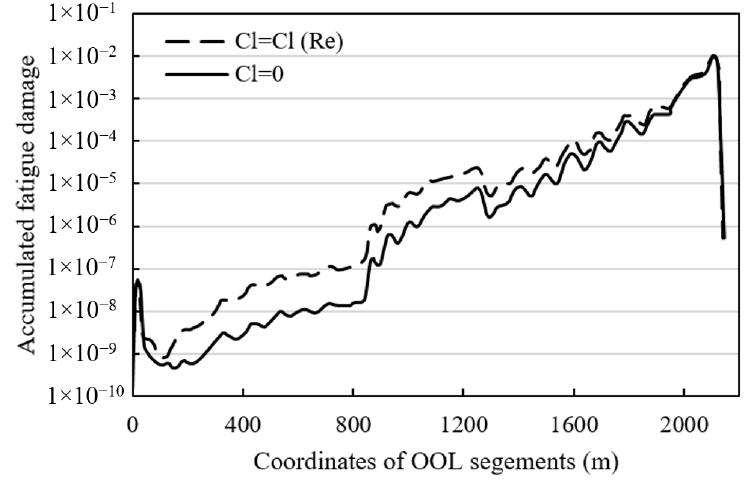
Figure 20. Fatigue damage distribution of OOL under current loads (45°).